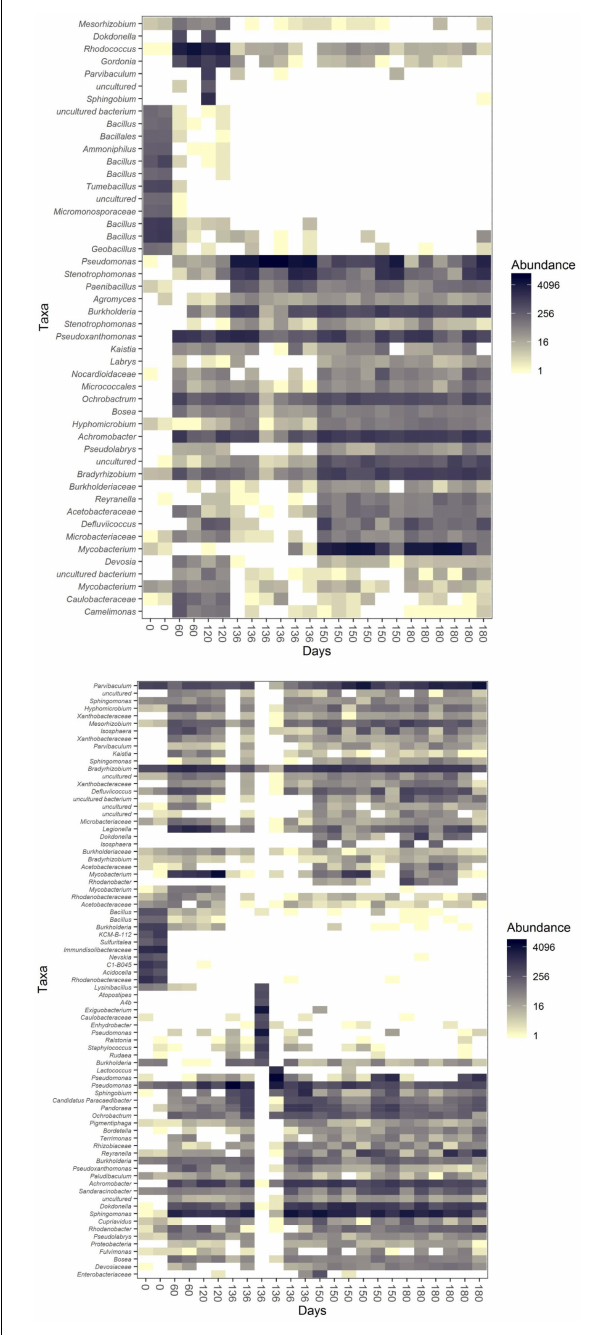
FIGURE 5 | Heatmaps [based on the Jensen–Shannon divergence (JSD) distance] of community U (top) and community P (bottom) during incubation 1 (0–120 days) and incubation 2 (120–180 days of the whole experiment, which correspond to day 0 and 60 days of incubation 2 itself in the data from the subsampled OTU